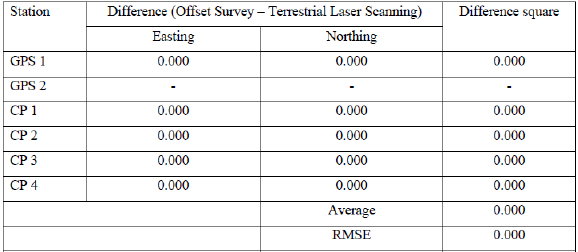
Table 3.4 Comparison of landscape maps 2022 vs 2018 for quantitative